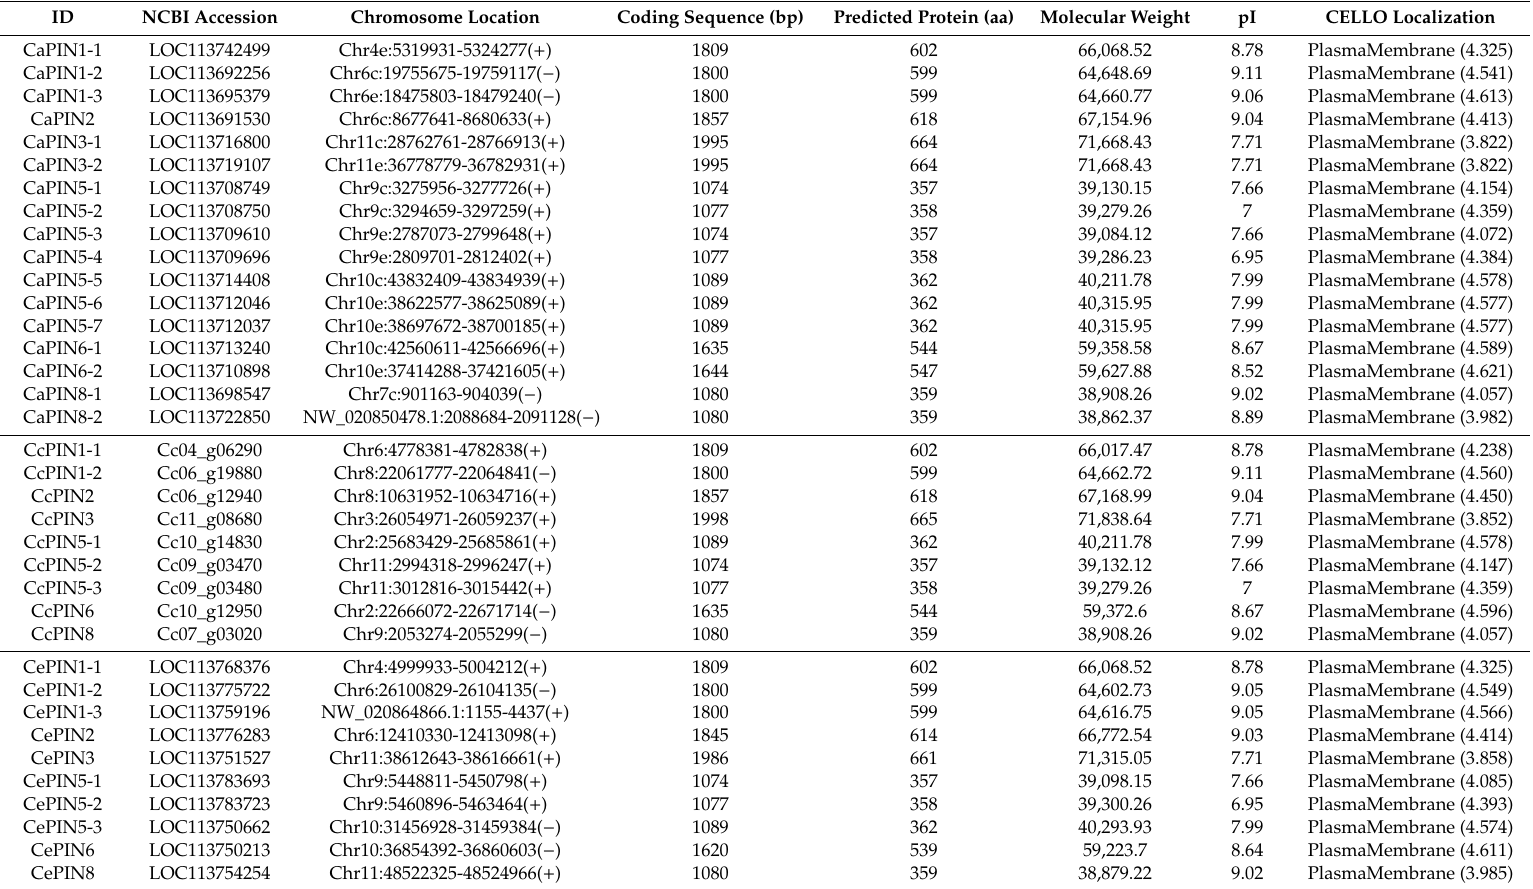
Table 1. Gene ID, accession, sequence length, molecular weight, theoretical isoelectric points (pI) and CELLO localization of co ff ee PINs